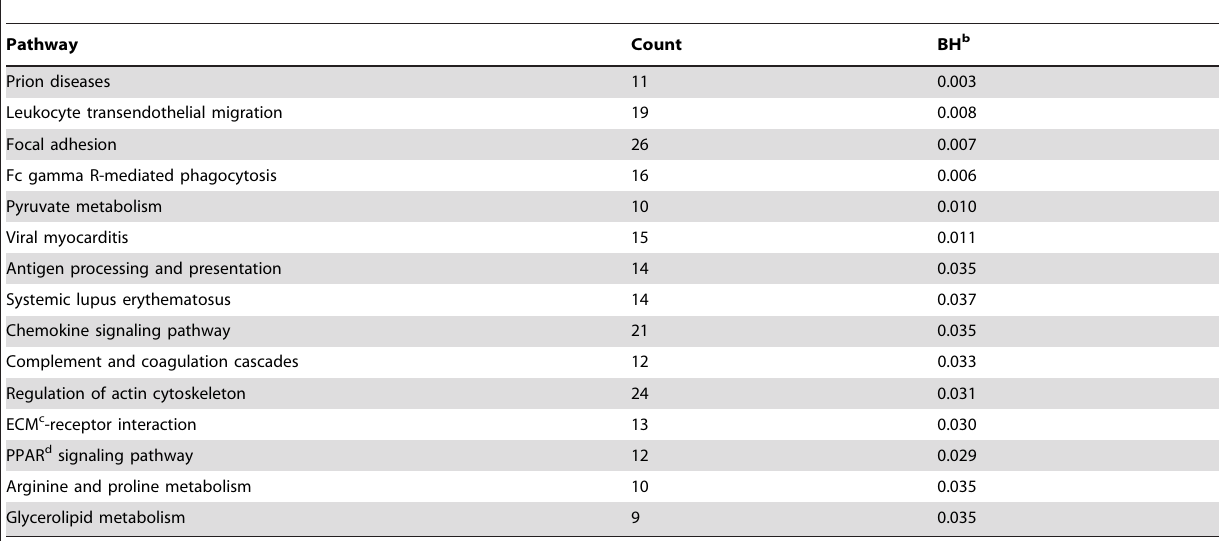
Table 2. KEGG a pathway enrichment for all genes relevant to liver fibrosis.